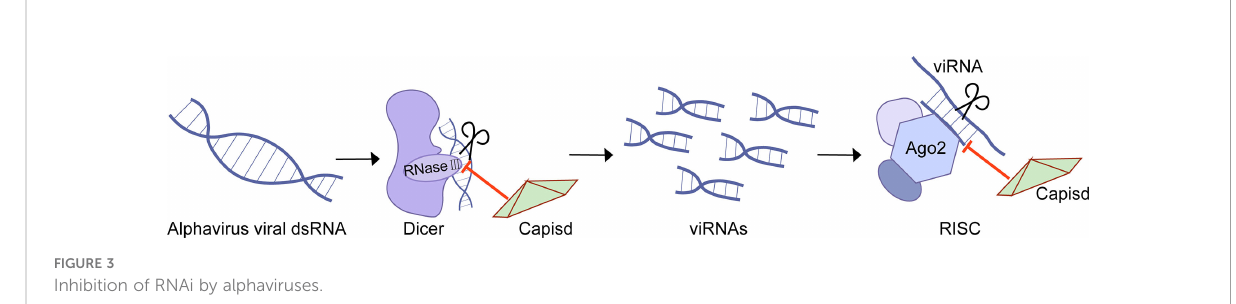
FIGURE 3 Inhibition of RNAi by